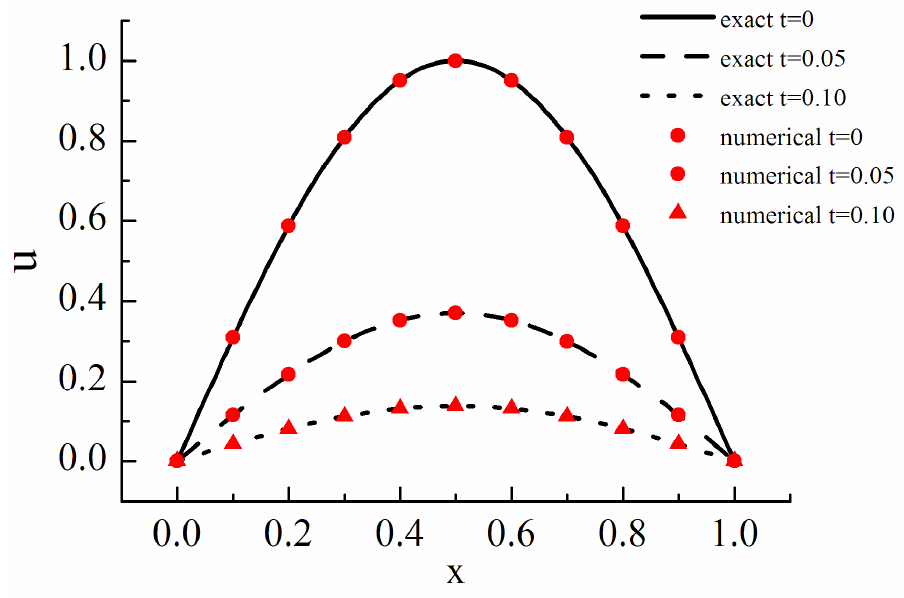
Figure 2. Diffusion reaction equation.